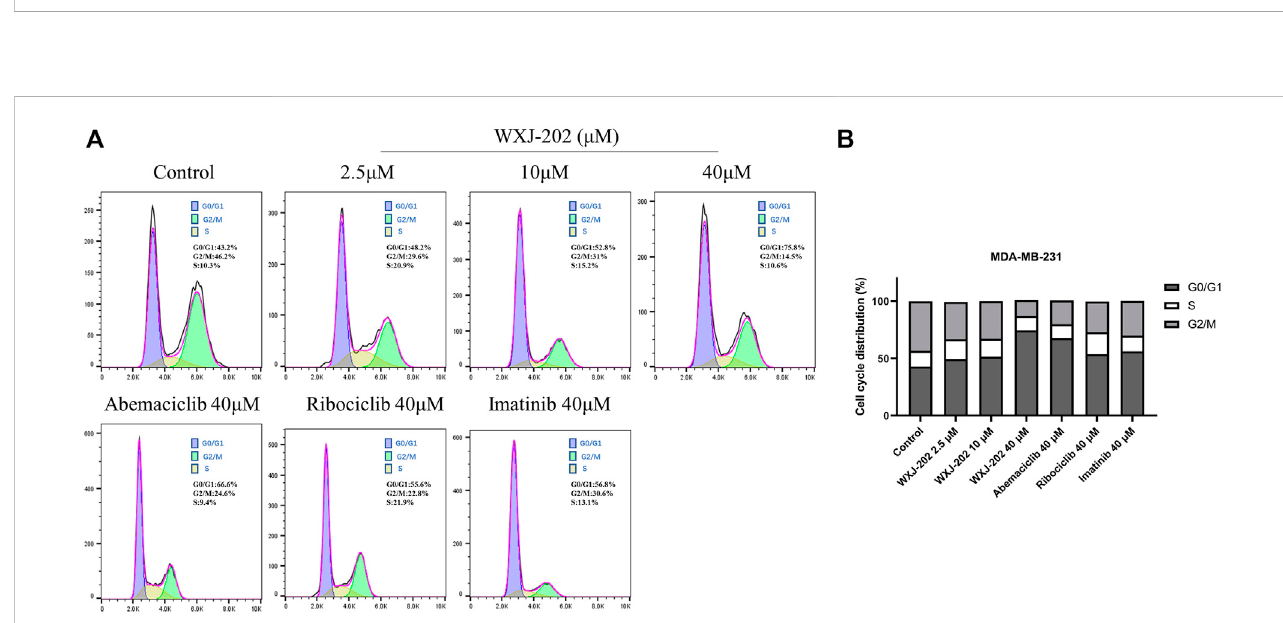
FIGURE 7 Effects ofcompound WXJ-202 on the cell cycle of MDA-MB-231 (A) Cell cycle analysis with Flow Cytometry. (B) The quanti fi ed histogram displayedthe cell cycle distribution. Data represent the mean ± S.D of at least three independent experiments.